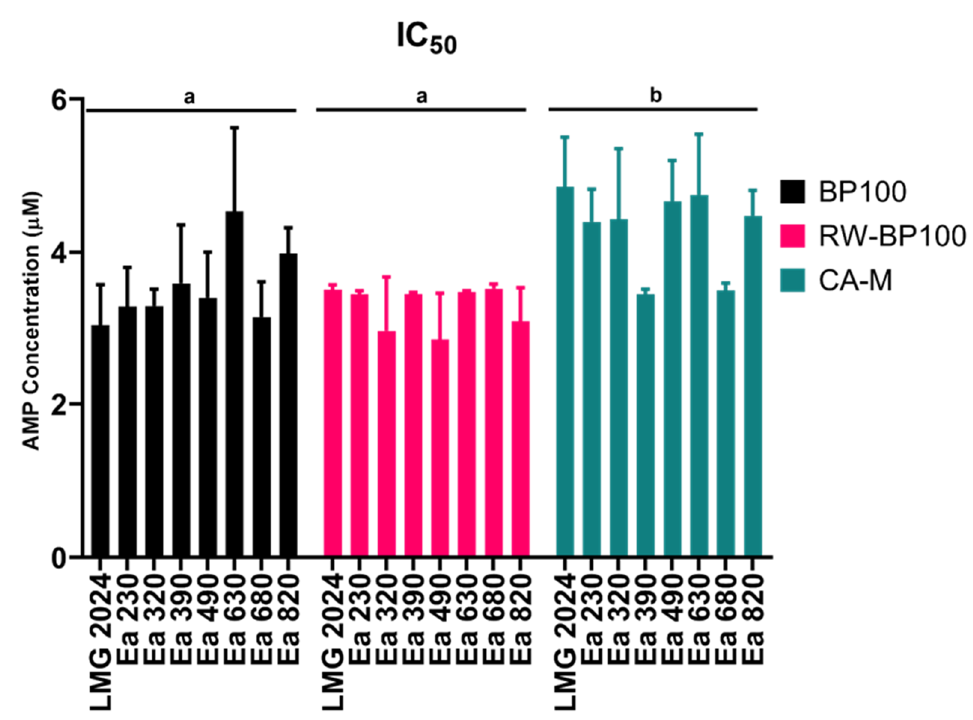
Figure 2. Half maximal inhibitory concentration (IC 50 ) of eight Erwinia amylovora strains against three AMPs: BP100, RW-BP100, and CA-M. Vertical bars: mean value with standard deviation ( n = 3). Different letters means significant differences for each AMP assay ( p < 0.0001).